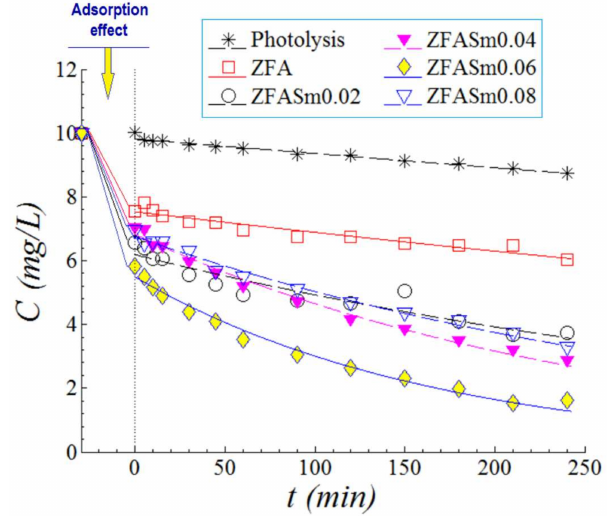
Figure 8. Kinetics of EB dye concentration decay versus irradiation time recorded during photolysis and photocatalysis processes under UV-Vis light; ZnAlFe 1 − x Sm x O 4 (x = 0, 0.02, 0.04, 0.06, 0.08) were used as photocatalysts; solid and dashed lines provide predictions according to PFO kinetic model; experimental conditions: catalyst dosage = 0.75 g/L; T = 25 ± 1 ◦ C. Table 2. Kinetic parameters for EB dye photodegradation under UV-Vis light in the presence